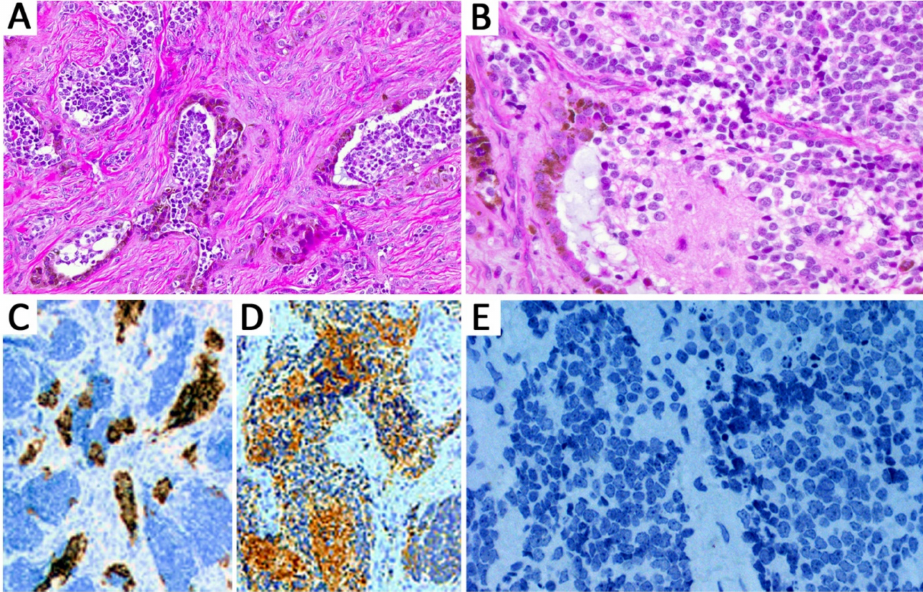
Figure 3. Melanotic neuroectodermal tumor of infancy (MNTI). Tumors showed a biphasic pattern composed of small round, neuroblast-like cells forming clusters/nests alternating with larger cells with more abundant cytoplasm and variable melanotic pigment in a dense fibrous stroma ( A , B ). All MNTIs had a large cell component consistently positive for HMB-45 ( C ). The small, neuroblast-like cell component was strongly reactive for synaptophysin ( D ), while Phox2b was constantly negative in all components ( E ).